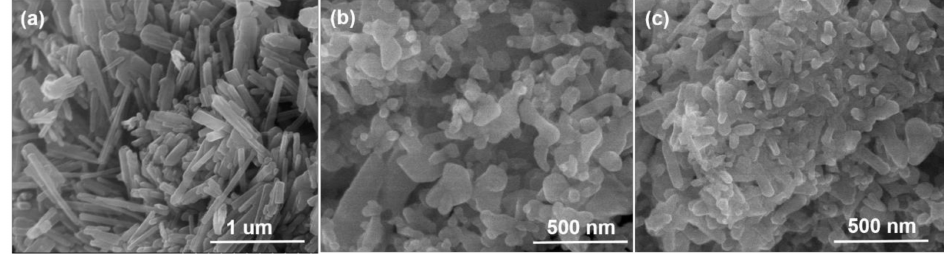
Figure 2. SEM images: ( a ) As-prepared ZnO nanorods; ( b ) g-C 3 N 4 /ZnO (0.1:1); and ( c ) g-C 3 N 4 /ZnO (0.1:1